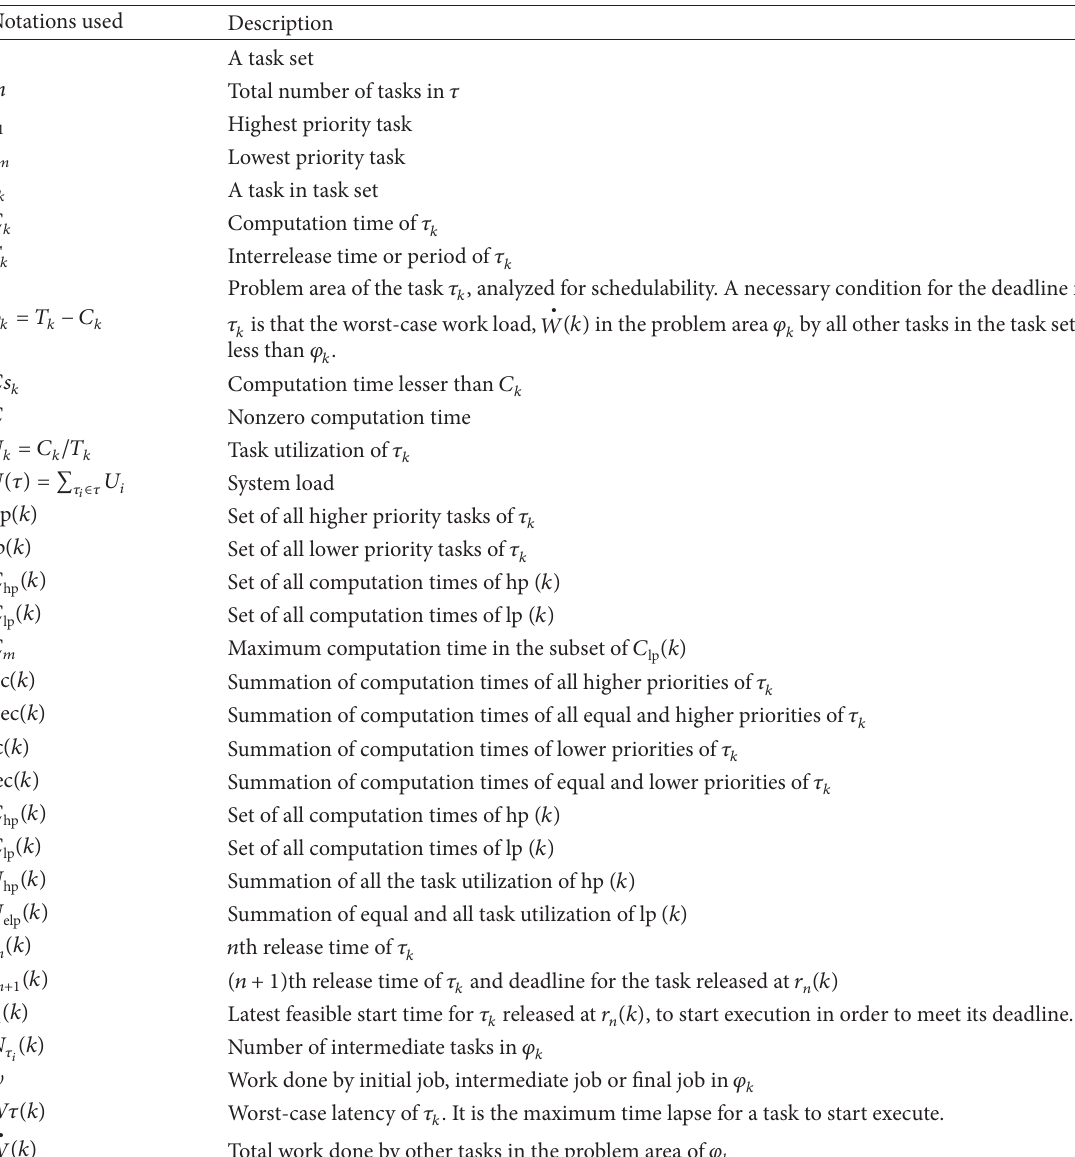
Table 1: Notations and